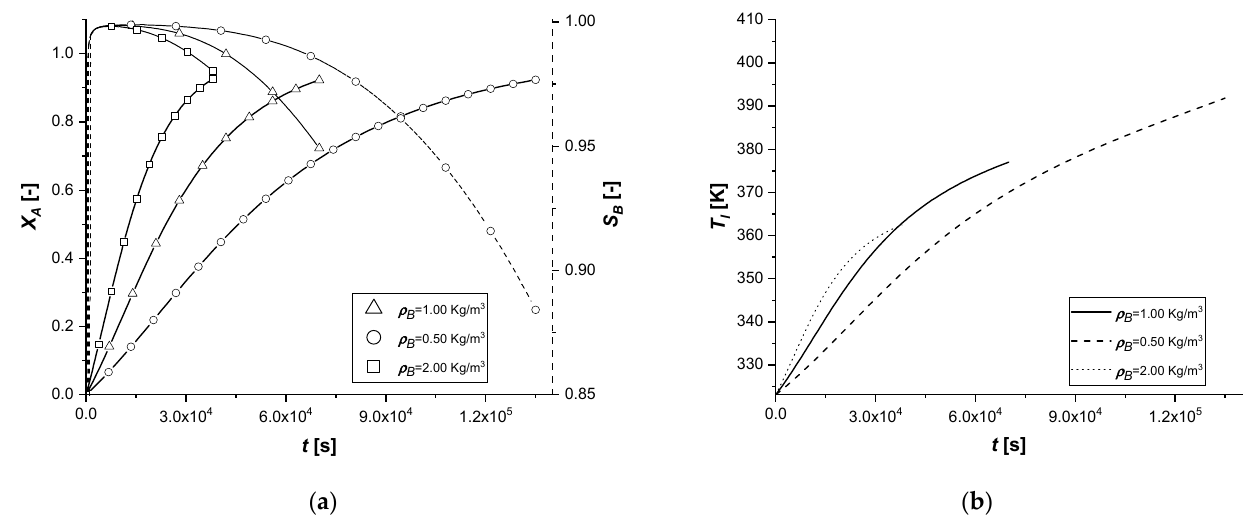
Figure 24. EW ρ P investigation. ( a ) Bulk profiles over time of X A and S B . ( b ) Bulk profile of T l over time.